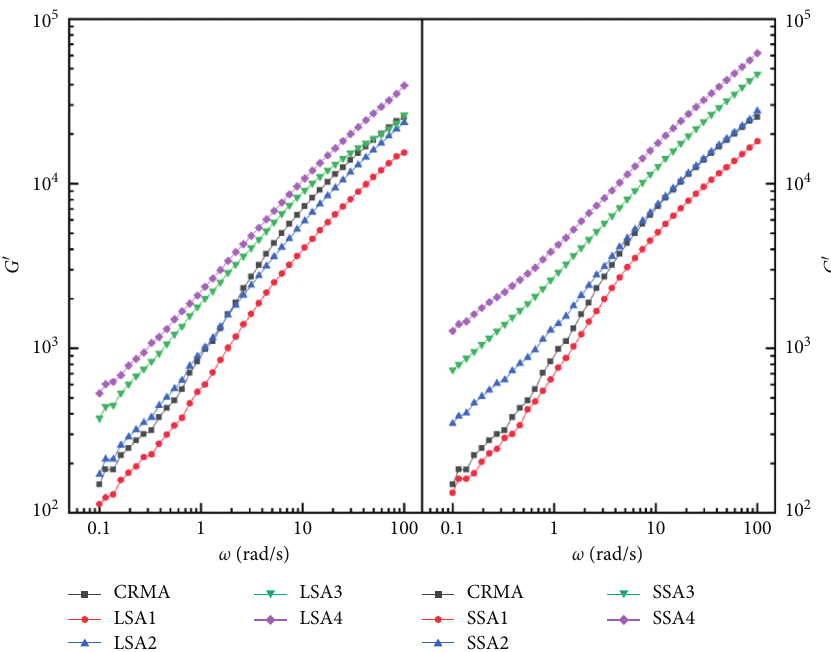
Figure 11: Variation of G ′ with the SBS contents for modified asphalts.